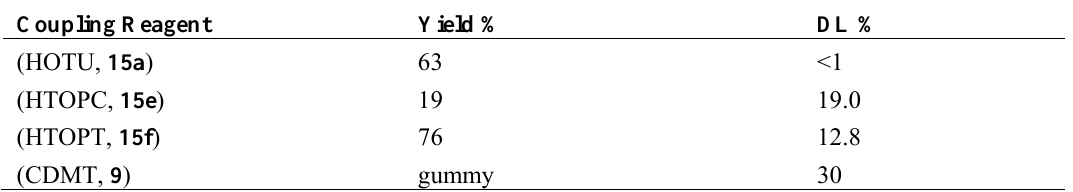
Table 3. Yield (%) and Racemization of (%) Z -Gly-Phe-Ala-OMe ( 17a ) using the Uronium Salts 15a,e,f and CDMT ( 9